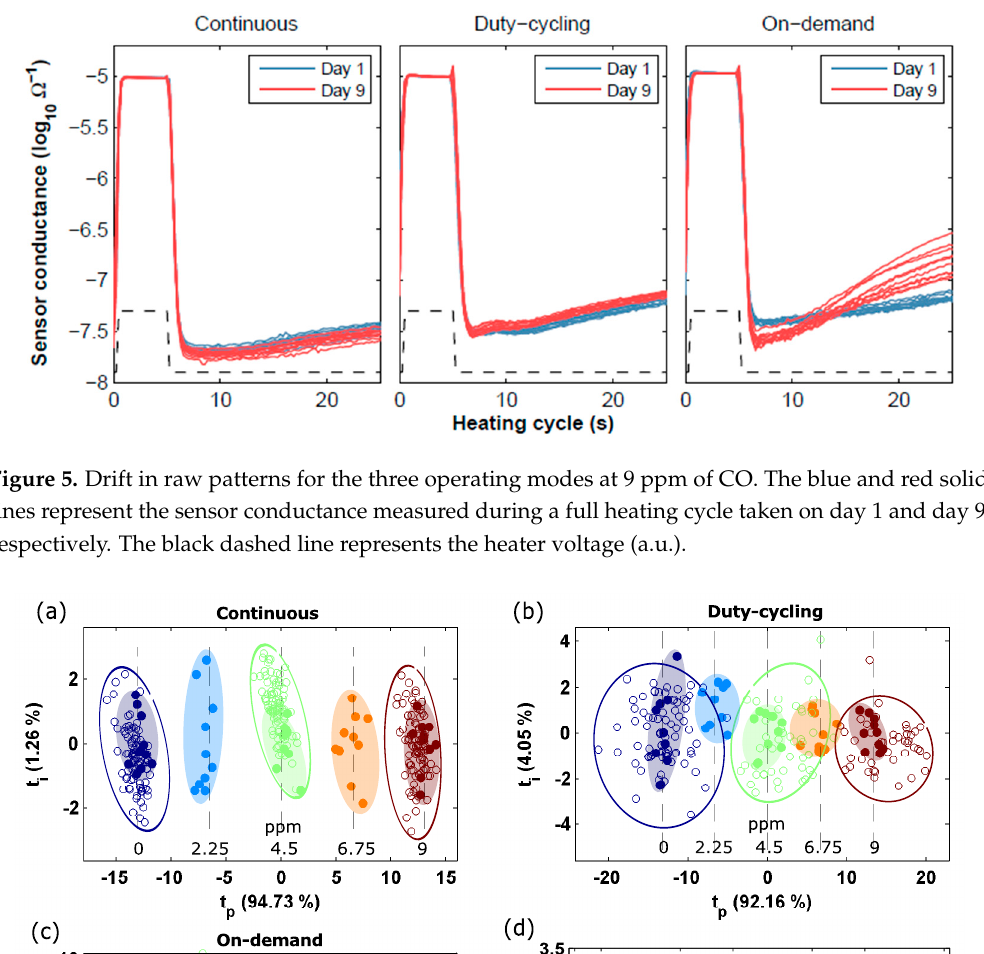
(2) where (cid:1866) denotes the size of the test set, and (cid:1877) (cid:3036) and (cid:1877)(cid:3548) (cid:3036) are the true and predicted values for the test sample (cid:1861) . The optimum number of LV was found by inspection of the graph of mean RMSE (across the bootstrap iterations) versus the number of LV. The stability of the calibration models was evaluated through the root mean squared error in prediction (RMSEP) using external validation samples collected in the two weeks following calibration. The RMSEP was computed using Equation (2), but in this case (cid:1866) denotes the size of the external validation set and (cid:1877) (cid:3036) and (cid:1877)(cid:3548) (cid:3036) are the true and predicted values for the external validation sample (cid:1861) . PLS models usually require several latent variables to account for the effect that chemical interferences produce in the sensor response patterns. When the model complexity increases beyond the chemical rank of the problem, PLS models are not easily interpretable [55]. A simpler model is advantageous to understand the underlying structure. To address this problem, the PLS models were post-processed with an orthogonalization step [56] that reduced the effective number of latent variables to two [57]. This produces simpler models with orthogonalized loadings and scores, which condense all the variance related to the target analyte into the first weight and loading. The first loading is in the same direction as the regression vector for data in which the structured noise, defined as the systematic variation of X not linearly correlated with Y , has been filtered out. The second loading of the orthogonalized model captures the variation orthogonal to Y, which is mainly related to the interferences and, to a lesser degree, other noise sources. The orthogonalized model yields the same predictions as the non-orthogonalized model. 3. Results and Discussion 3.1. Drift in Sensor Conductance Patterns The response of the sensors to the experimental conditions described in Figure 3 was recorded for